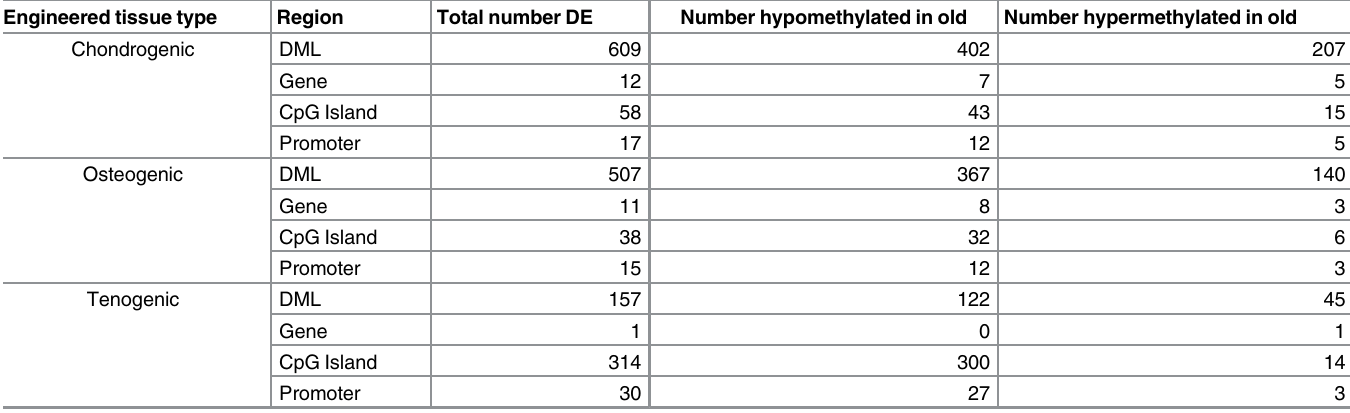
Table 7. Number of age-related differentially methylated loci (DML), genes, CpG islands and promoters. Engineered tissue type Region